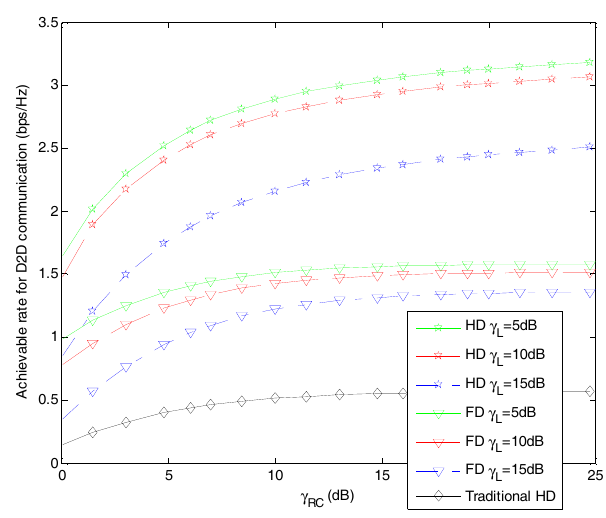
Figure 5. The effect of channel quality from the D2D relay to the cellular user.